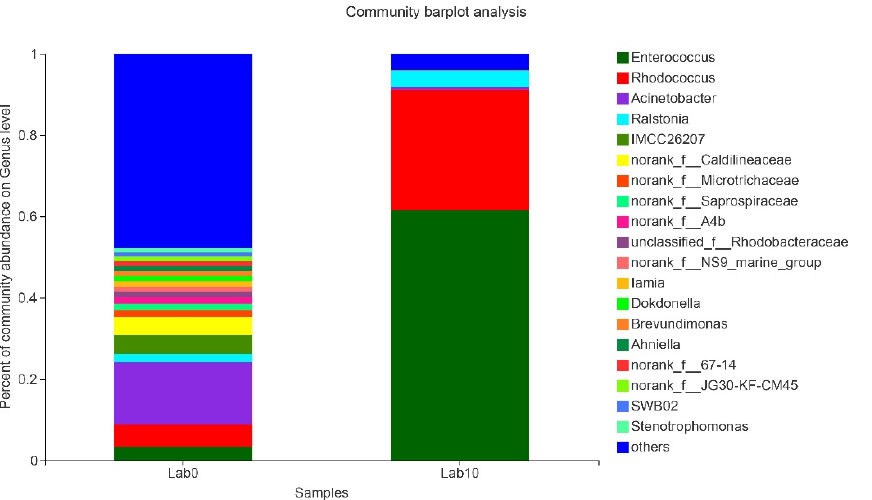
Figure 4. Relative abundance of bacterial composition of S. frugiperda after one year of laboratory rearing at the genus level.